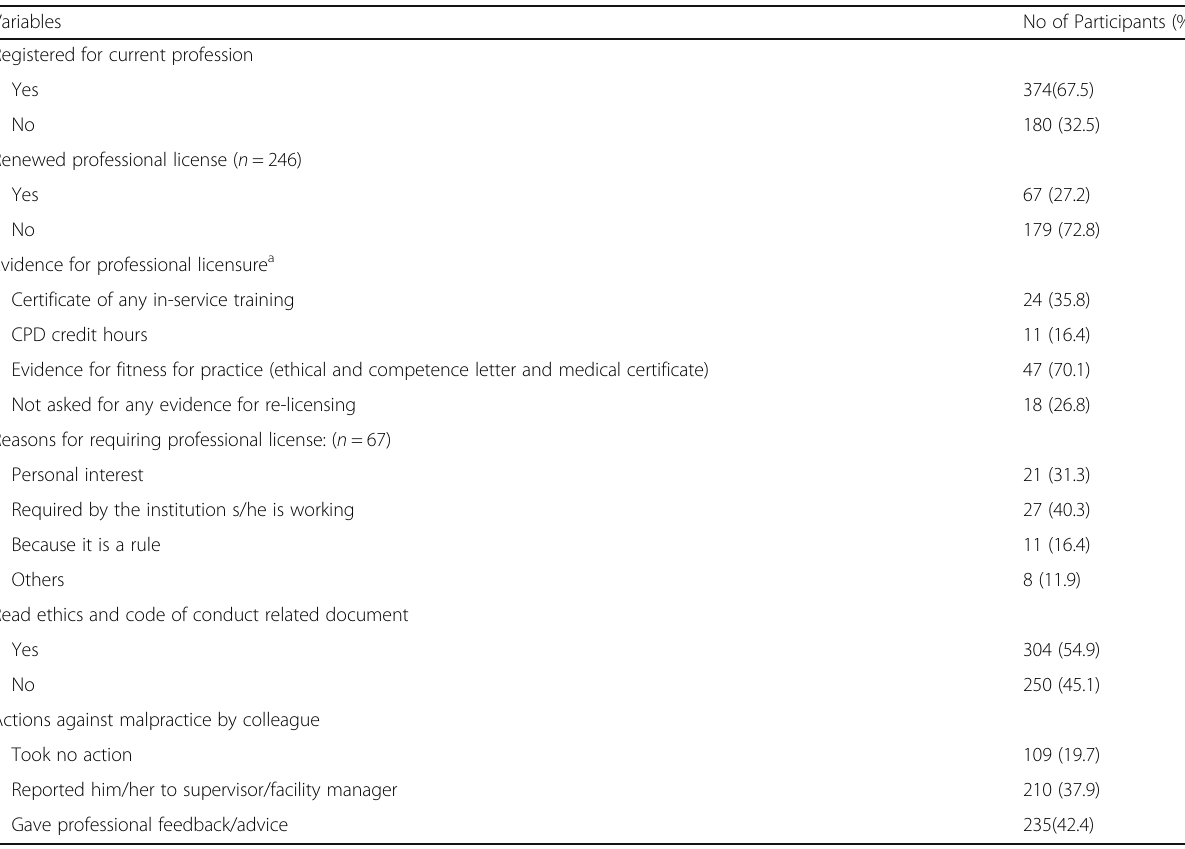
Table 2 Adherence to regulation requirements, exploring health workforce regulation practices and gaps, Ethiopia, 2015 ( N = 554)